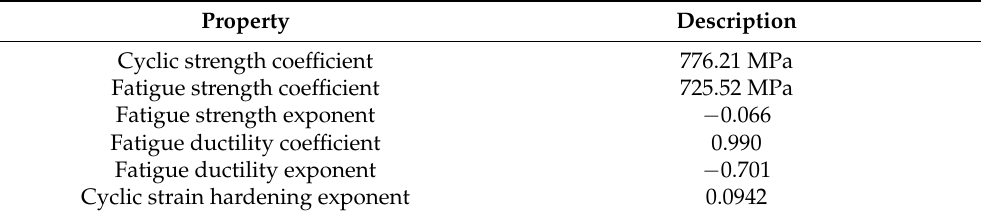
Figure 6. nCode ® Designlife ® analysis scheme used for vibration fatigue analysis. Table 4. Cyclic properties of Inconel 718